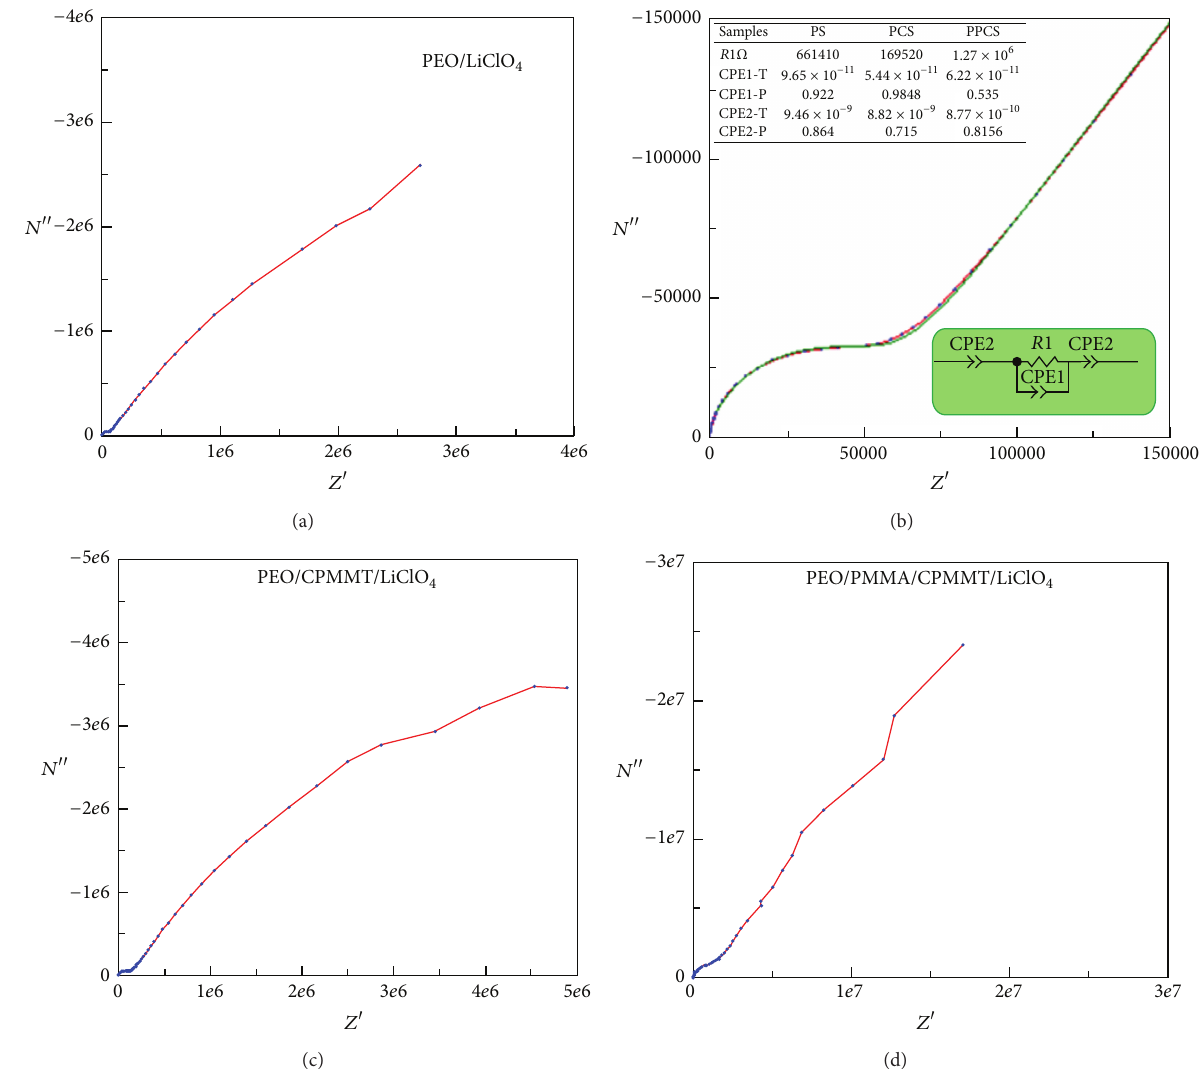
Figure 9: Typical Nyquist impedance plots for PEO/Salt (PS) (a), PEO/Salt (PS) after fitting to equivalent circuit (b). Inset showing that diagram of circuit and extracted parameters for the circuit elements of PS, PCS, and PPCS are summarized in the table. PEO/Salt/CPMMT (PCS) (c). PEO/PMMA/Salt/CPMMT (PPCS)